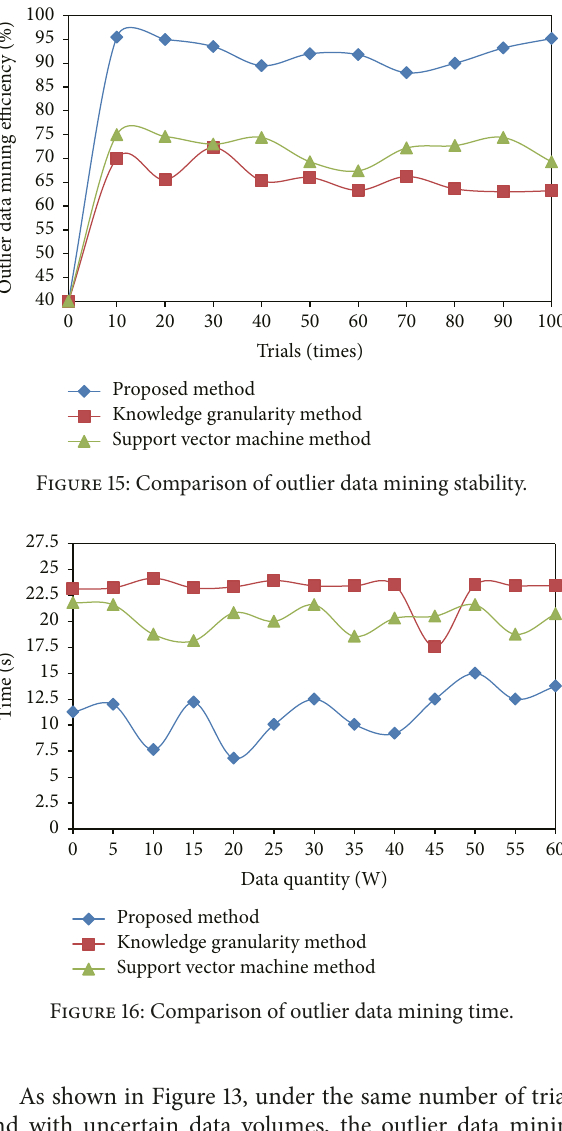
0.698 dB, respectively. The proposed method shows increases of 150% and 352% over the two traditional methods.